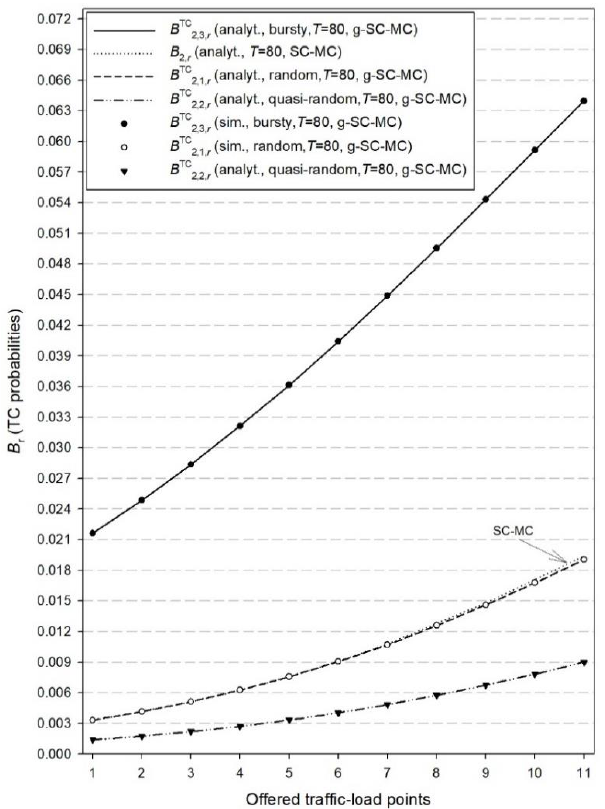
Figure 5. TC probabilities ( B TC